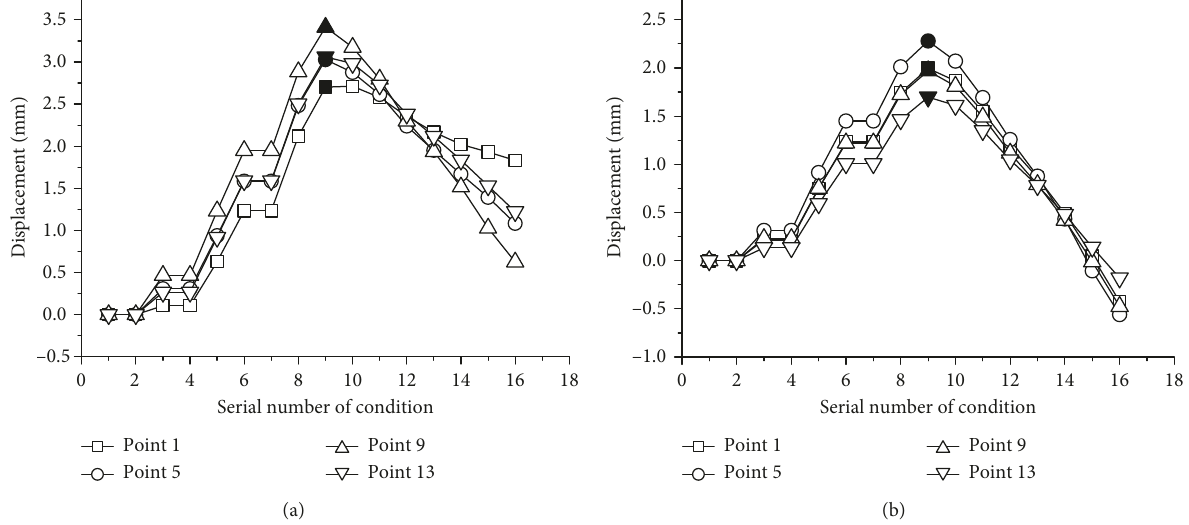
Figure 10: Time history of displacement of the tunnel in Scheme 2. (a) Horizontal displacement. (b) Vertical